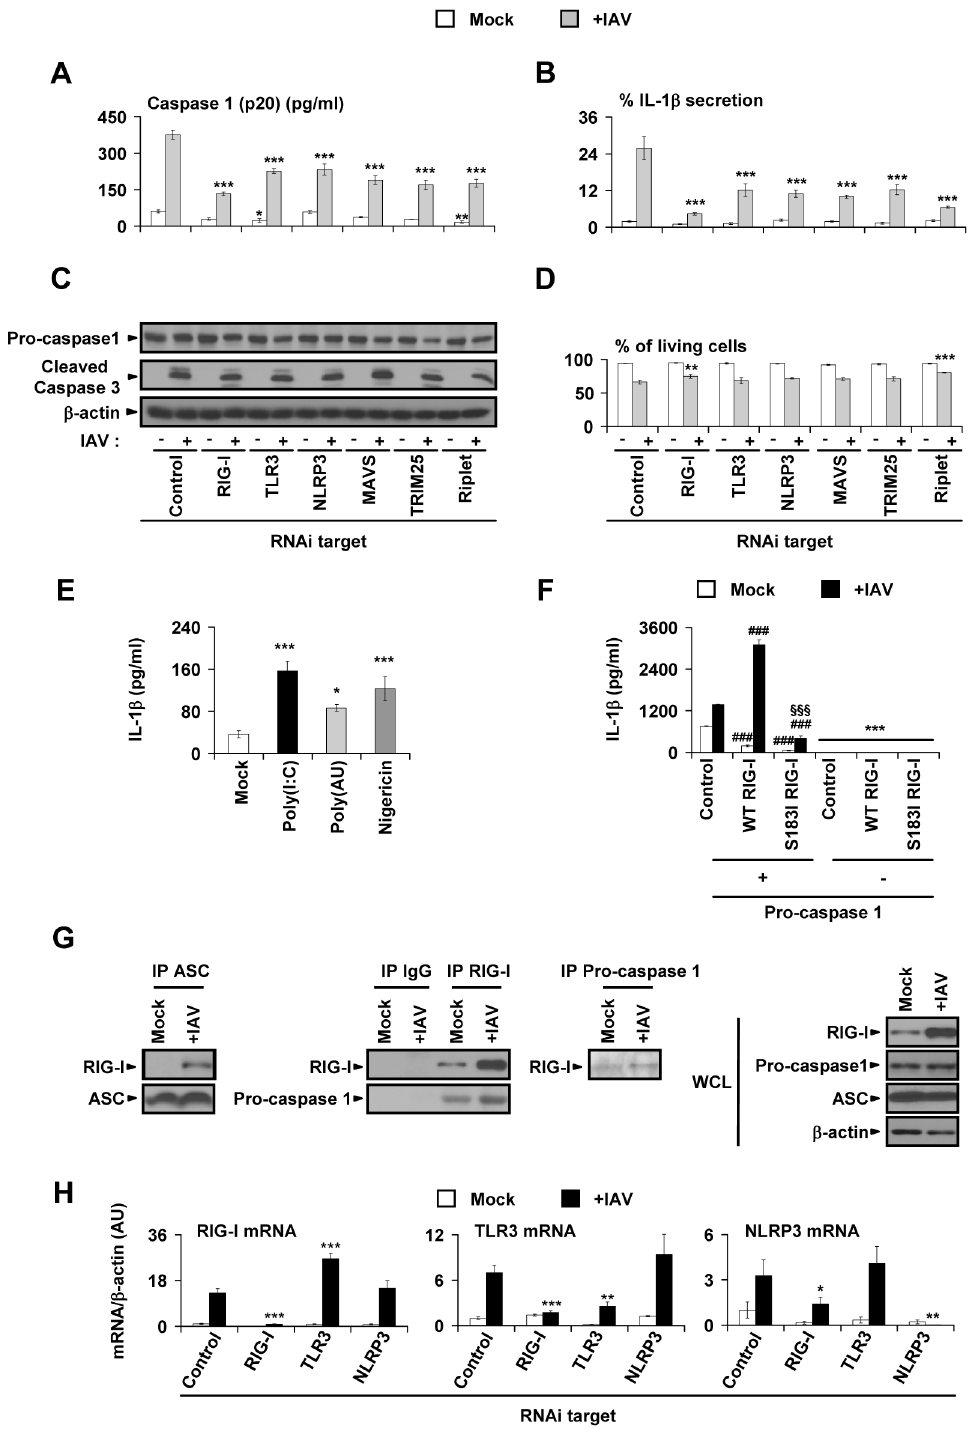
Figure 3. RIG-I-dependent caspase 1 activation is critically involved in IL-1 b response to IAV. (A–D) NHBE cells were first transfected with either a control or one of the experimental siRNA, and then either mock-treated ( 2 ) or infected with USSR ( + IAV). At 18 h post-infection or mock treatment, the following were measured in the cell-free supernatant: (A) Cleaved caspase 1 p20; (B) Ratio of secreted IL-1 b normalized with respect to total IL-1 b production (intracellular and secreted IL-1 b ), expressed as a percentage (concentration measurements are provided in supplementary Tables S2 and S3). (C) Immunoblot detection of pro-caspase 1, cleaved caspase-3, and b -actin expression. (D) Percentage of living NHBE cells determined by LDH assay (calculation is detailed in the supplemental experimental procedures file). (A–D) Experiments were performed on 3–5 NHBE donors, * p , 0.05, ** p , 0.01, and *** p , 0.001, comparing mock-treated or IAV-infected cells transfected with specific siRNAs to their control siRNA- transfected counterparts. (E) ELISA quantification of IL-1 b in the cell-free supernatant derived from NHBE cells following 22 h of either mock- treatment or stimulation with either the TLR3 ligands Poly(I:C) (5 m g/ml) or Poly(AU) (100 m g/ml), or the NLRP3 ligand nigericin (10 m M). The data are representative of three independent experiments and presented as mean 6 SEM of triplicates with cells from three donors (75008, 118008, and